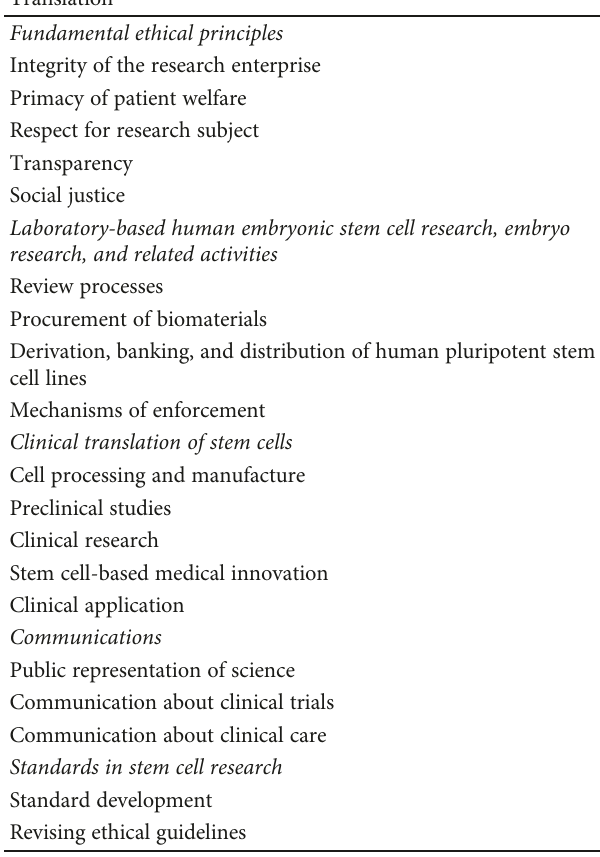
Table 1: Main issues from ISSCR 2016 “ Guidelines for Stem Cell Research and Clinical Translation ” . ISSCR — Guidelines for Stem Cell Research and